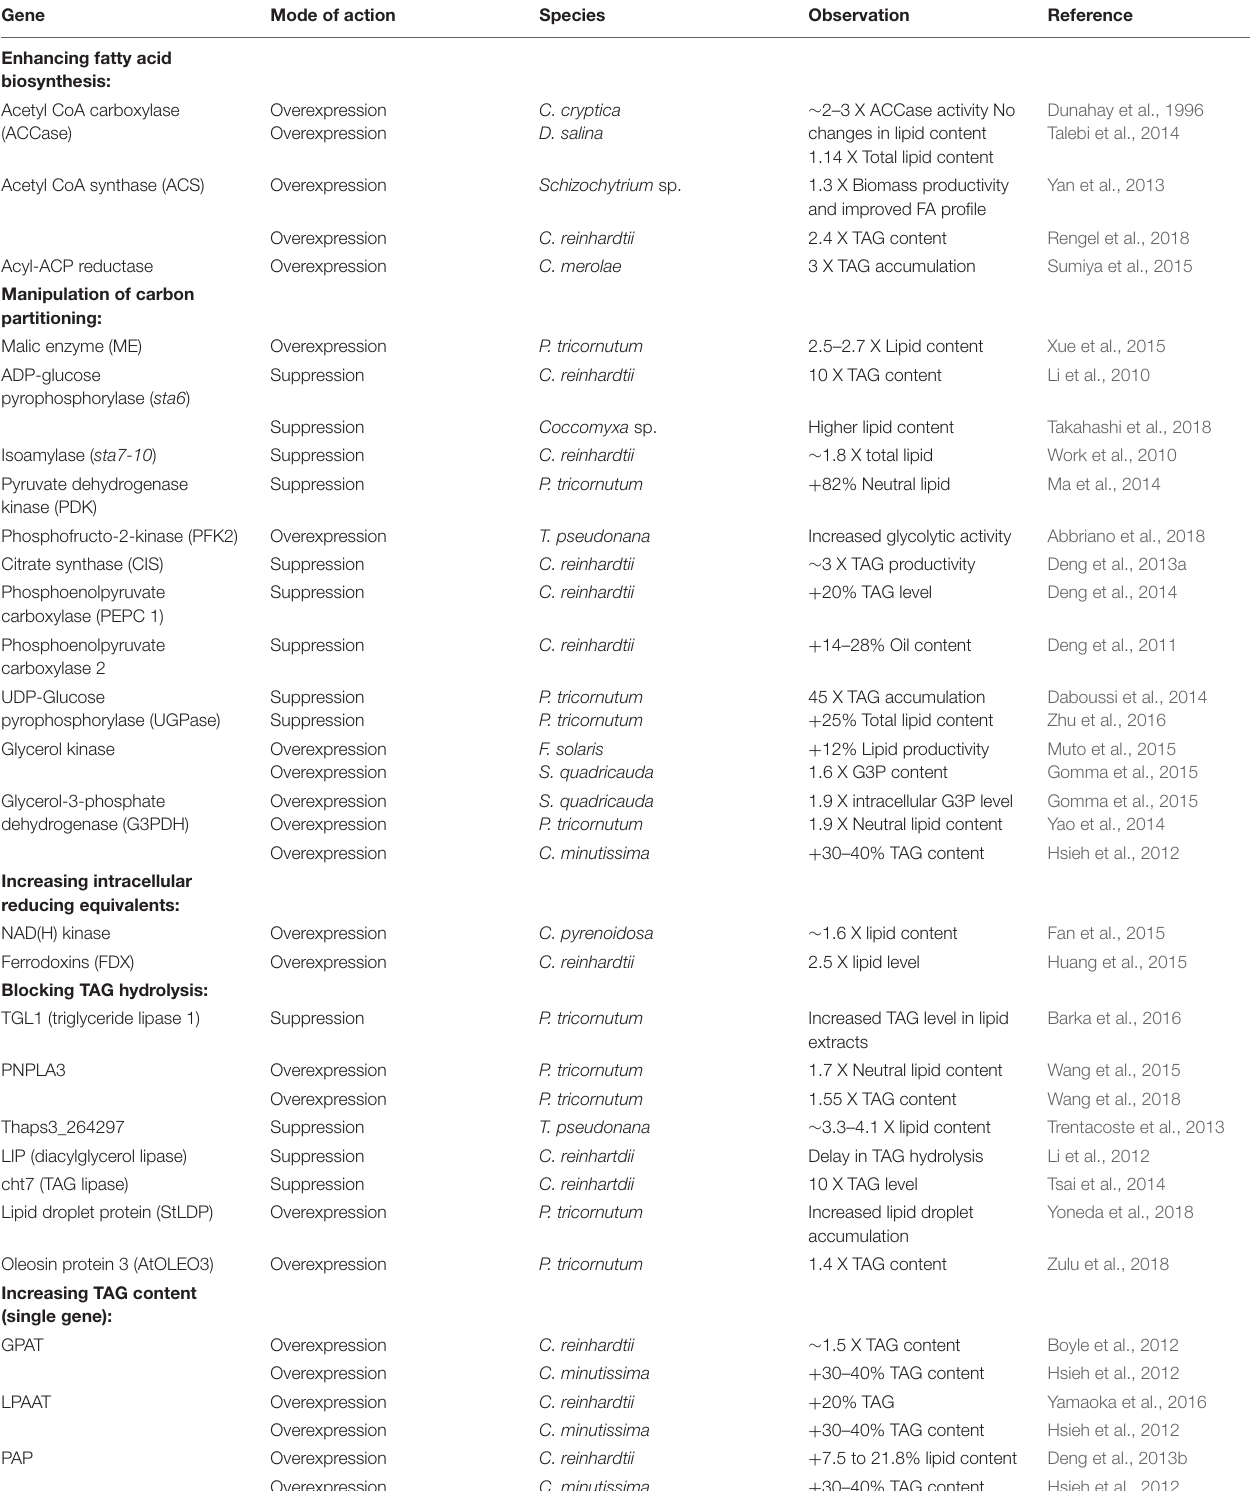
TABLE 1 | Summary of genes manipulated for oil